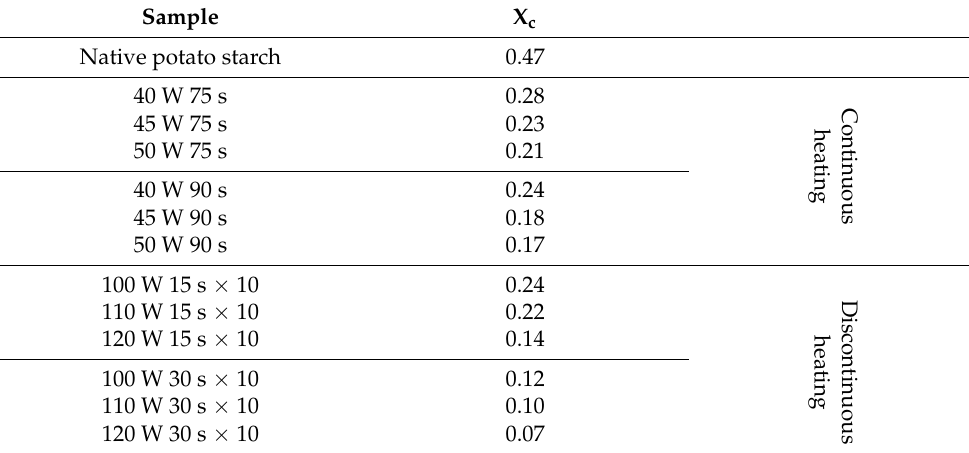
Table 2. Values of crystallinity index (X c ) dextrins prepared under continuous and discontinuous microwave-assisted heating and native of potato